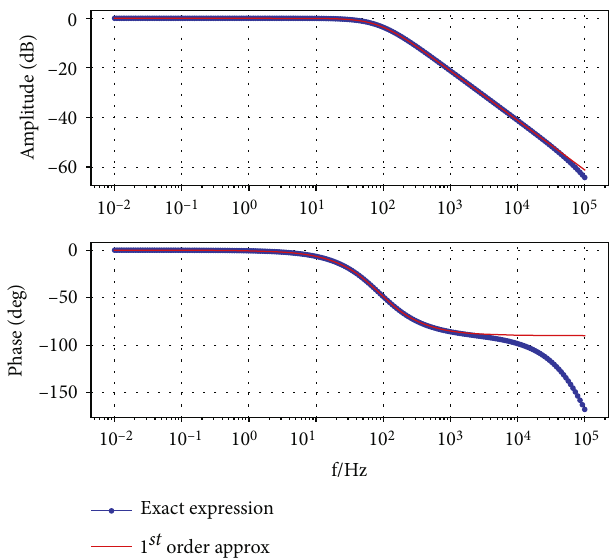
Figure 5: Bode plot comparison: equation (61) in blue vs. equation (57) in red. Top: amplitude; bottom: phase.